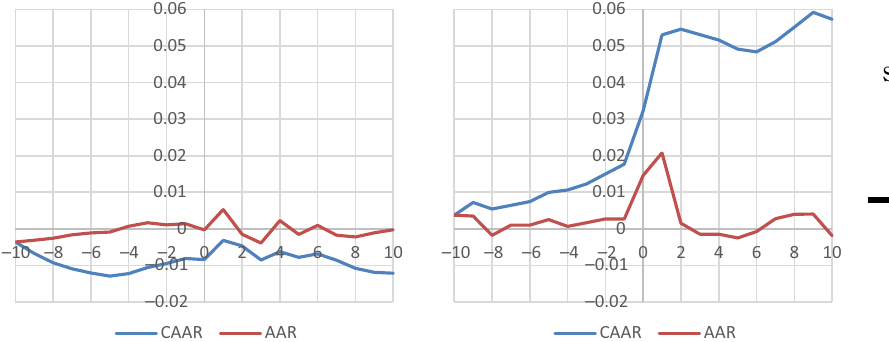
Figure 4. Market reaction